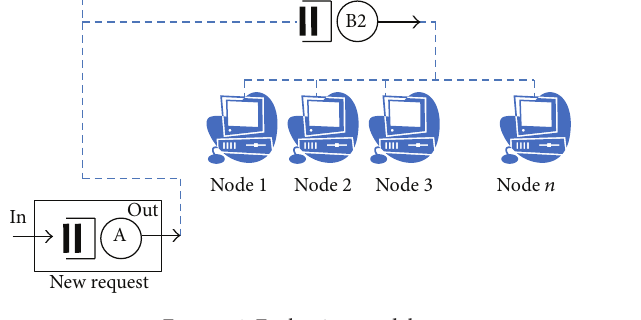
Figure 4: Evaluation model.